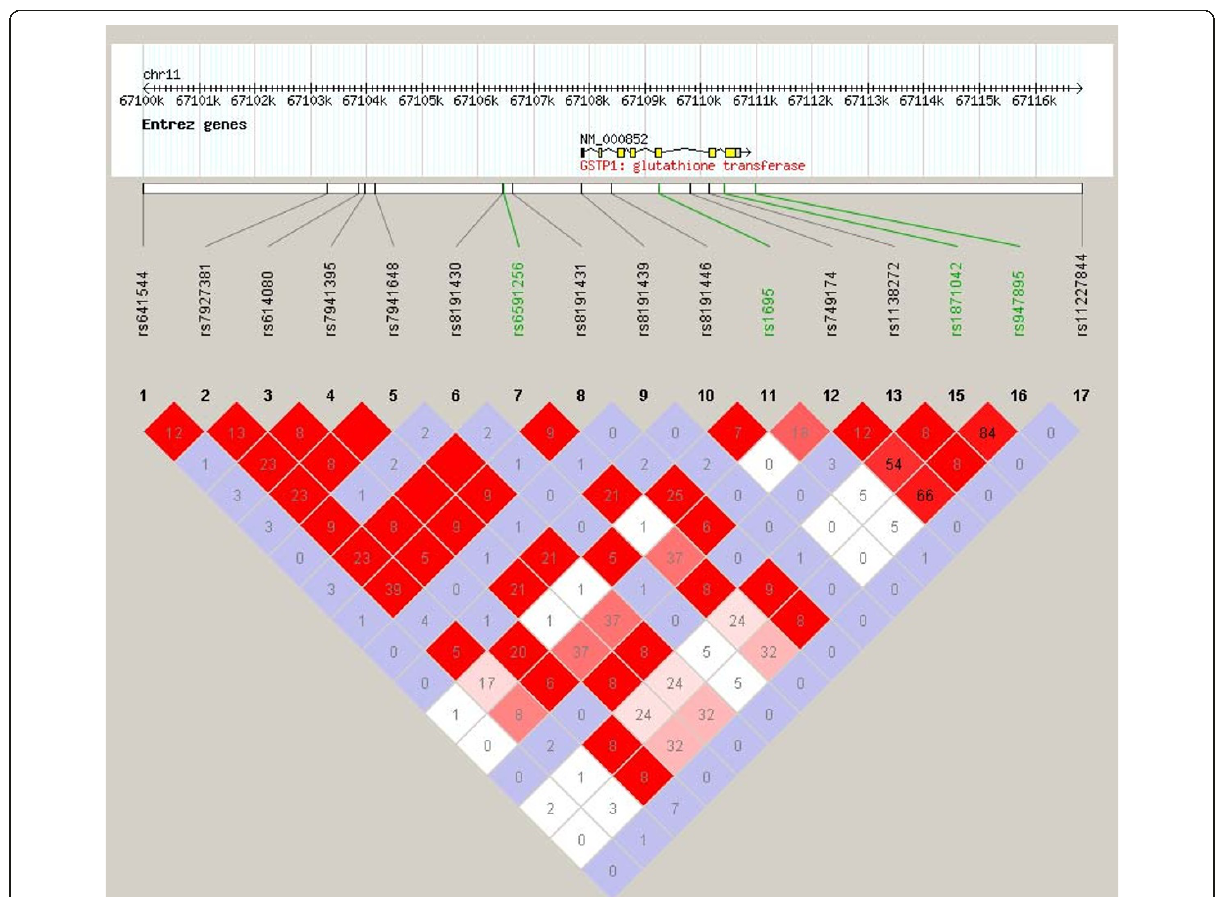
Figure 3 Linkage disequilibrium (LD) observed across SNPs of GSTP1 . r 2 values displayed in triangle plot represent strength of LD between SNPs. Color scheme: white (weakest LD): D ’ < 1, LOD < 2; blue: D ’ = 1, LOD < 2; shades of pink/red: D ’ < 1, LOD ≠ 2; bright red (strongest LD): D ’ = 1, LOD ≠ 2. SNPs in study population indicated in green, HapMap SNPs in black. HapMap data specific to the individuals of African ancestry from the South West United States (ASW)